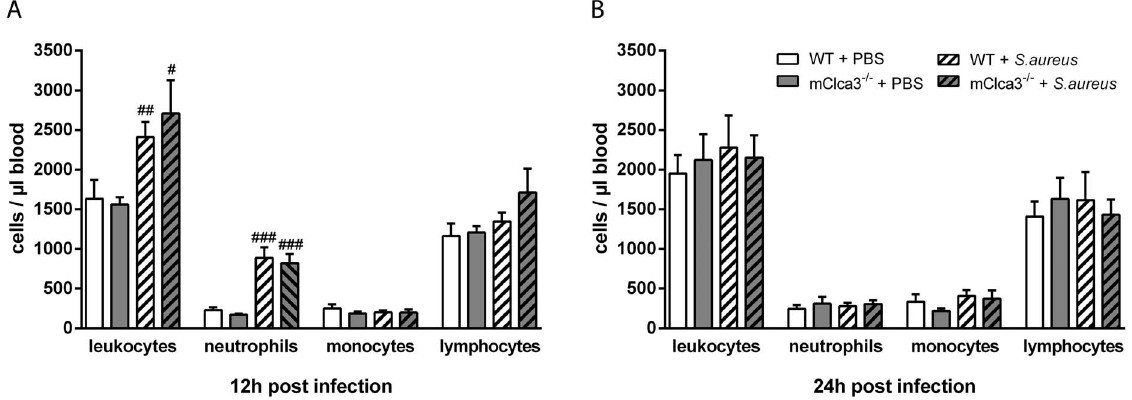
Figure 4. Early infection with S.aureus led to a comparable increase in systemic leukocyte response. (A, B) At indicated time points after infection, blood leukocyte numbers and subpopulations were determined by fluorescence-activated cell sorter (FACS). Values are given as mean 6 SEM (n=8 each group). # p , 0.05, ## p , 0.01, ### p , 0.001 versus the PBS-treated control group.